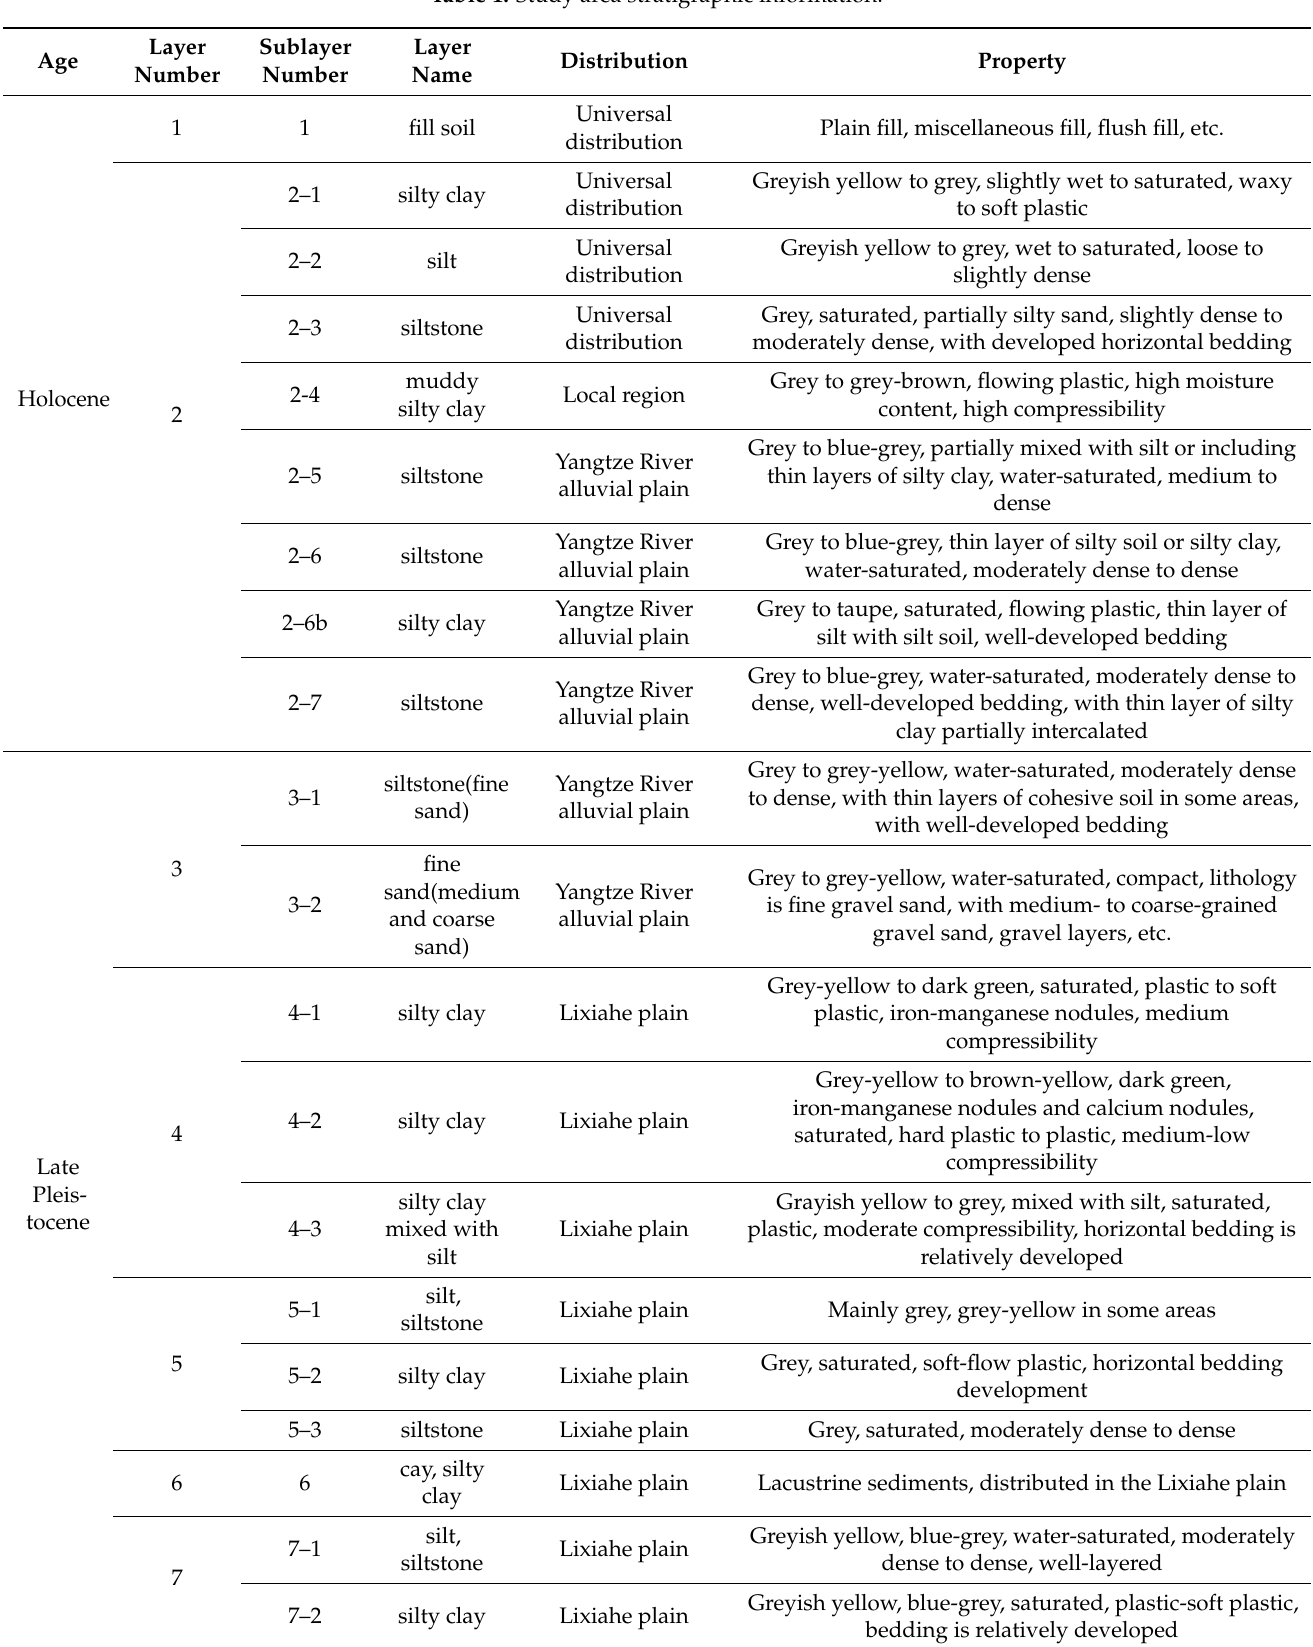
Table 1. Study area stratigraphic